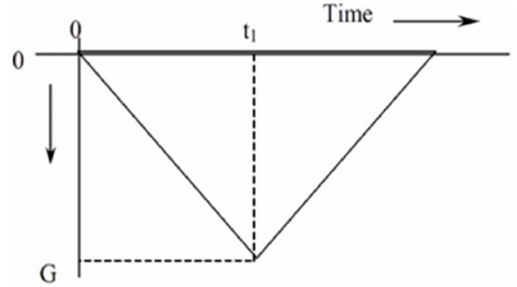
Figure 5. Curve of the acceleration applied to the seat over time.